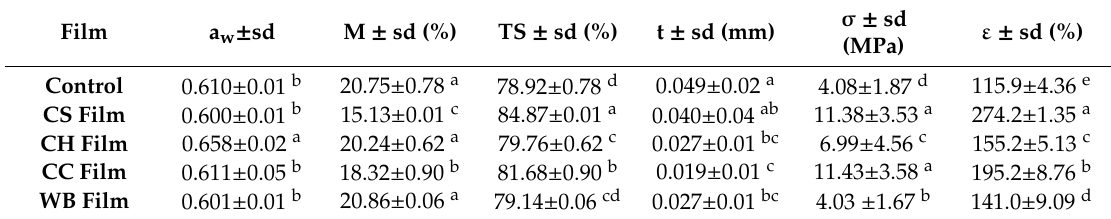
Table 6. Characterization of nanobiocomposites (mean ± standard deviation).